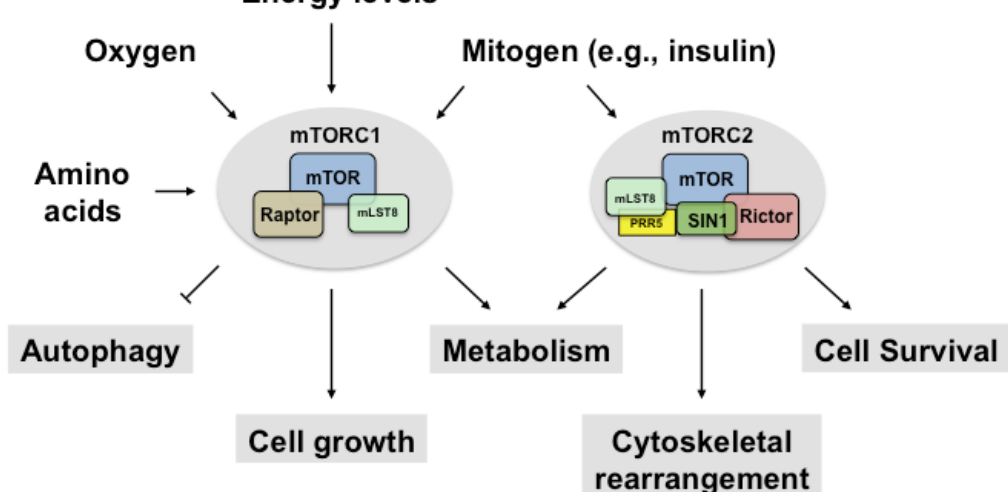
Figure 1. mTORC1 and mTORC2. mTOR is a serine/threonine kinase that forms two biochemically and functionally distinct complexes. mTORC1 consists of mTOR, raptor, mLST8 and the two inhibitory subunits, PRAS40 and DEPTOR, whereas mTORC2 consists of mTOR, rictor, mLST8, PRR5, SIN1 and the inhibitory subunit, DEPTOR. mTORC1 senses mitogens, oxygen levels, intracellular energy status, and amino acids to promote cell growth by regulating anabolic and catabolic processes. mTORC2 is activated by mitogen and controls cell survival, metabolism, and cytoskeletal organization. The inhibitory subunits in mTOR complexes are not presented here (PRAS40, DEPTOR). mTOR; mammalian target of rapamycin; mTORC1, mTOR complex 1; mTORC2, mTOR complex 2; mLST8, mammalian lethal with Sec13 protein 8; PRR5, proline-rich protein 5; SIN1, stress-activated map kinase-interacting protein 1; PRAS40, proline-rich Akt substrate of 40 kDa; DEPTOR, DEP domain-containing mTOR-interacting